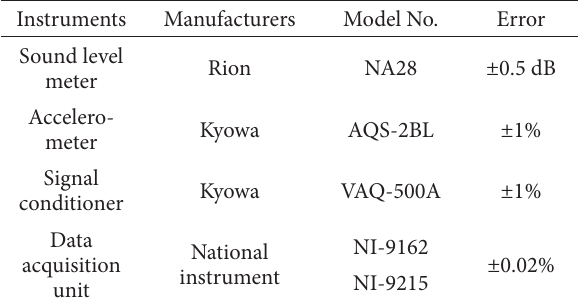
Table 1. Details of the measuring instruments